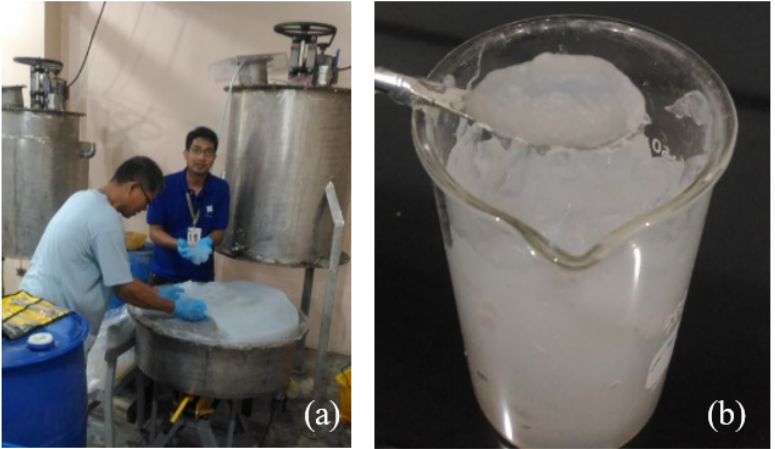
Figure 1. Large scale production of NC-TEMPO ( a ) collection of CNF-TEMPO; ( b ) gel like CNF- TEMPO